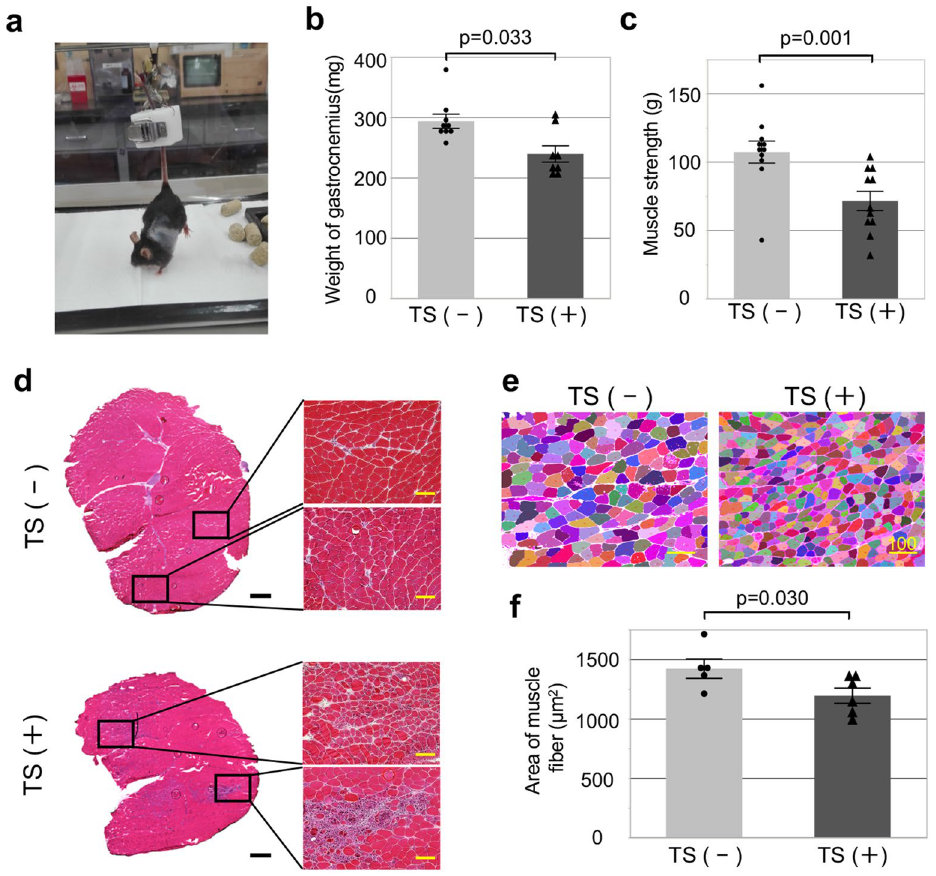
Figure 1. Skeletal muscle atrophy due to sustained tail-suspension after I/R. ( a ) Experimental sarcopenia was induced via using the modified Morey’s tail-suspension (TS) model. Analysis of the weight of the gastrocnemius ( b ) and of the limb strength ( c ) in TS (+) (n = 8) and TS (−) (n = 9) mice. Left bar; TS (−), Right bar; TS (+). ( d ) An evident reduction of the myofiber cross-sectional area (CSA) was observed in TS (+) mice. Histological findings of the gastrocnemius of TS (+) (lower) and TS (−) (upper) mice. Left side; cross-section of the gastrocnemius; scale bar = 500 μm. Right side; enlarged figure of the myofibers; scale bar = 100 μm. ( e ) Automatic detection of the CSA of myofibers using the BZ-X Analyzer software (Keyence. Co.). Scale bar = 100 μm. ( f ) Analysis of the CSA of the myofibers. Left bar; TS (−), Right bar; TS